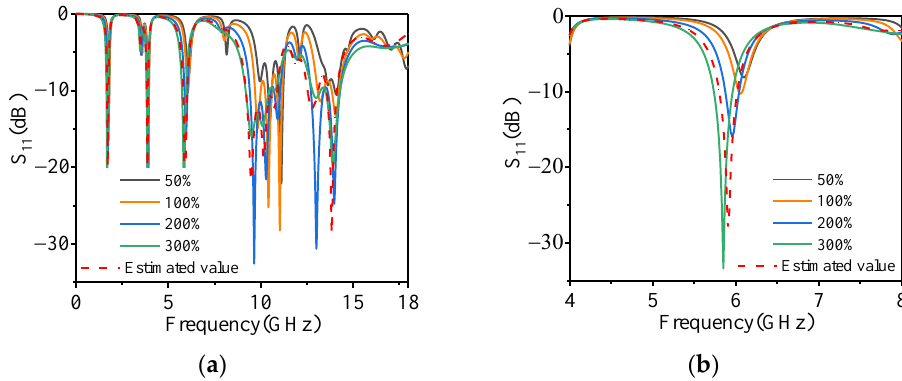
Figure 10. The absorbing properties of the absorber loaded with different types of magnetic substrates; ( a ) is 0–18 GHz, and ( b ) is 4–8 GHz.